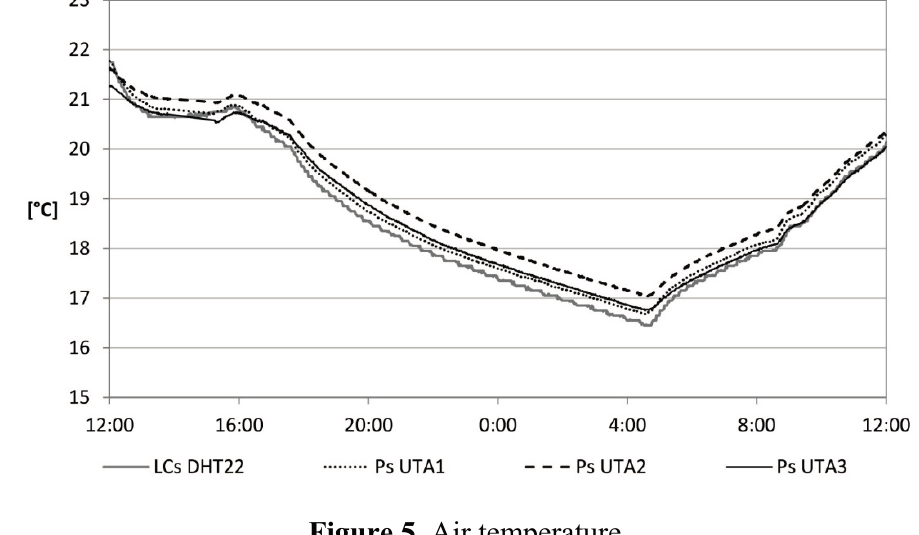
Figure 5. Air temperature.